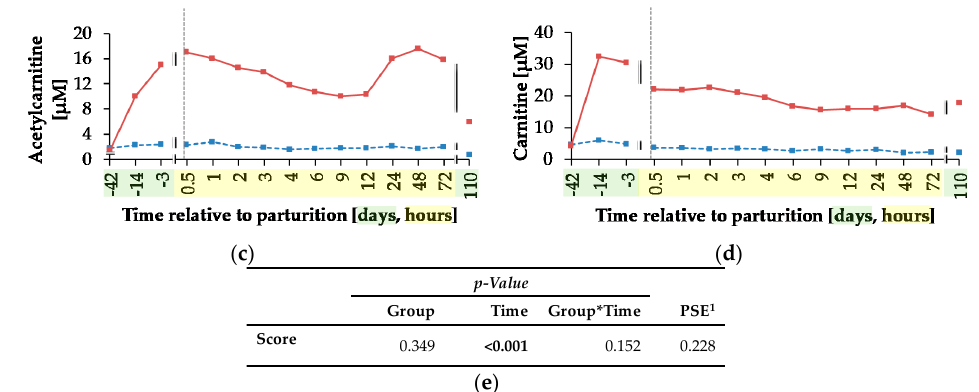
Figure 6. Concentrations of ( a ) N ε -trimethyllysine (TML), ( b ) y-butyrobetaine (yBB), ( c ) acetylcarnitine and ( d ) L-carnitine in plasma of cows fed a non-supplemented (CON) or an L-carnitine-supplemented diet (25 g/d from 6 weeks ap up to week 15 pp , CAR). ( e ) Data statistics. Data are given as LS-means. 1 pooled standard error.